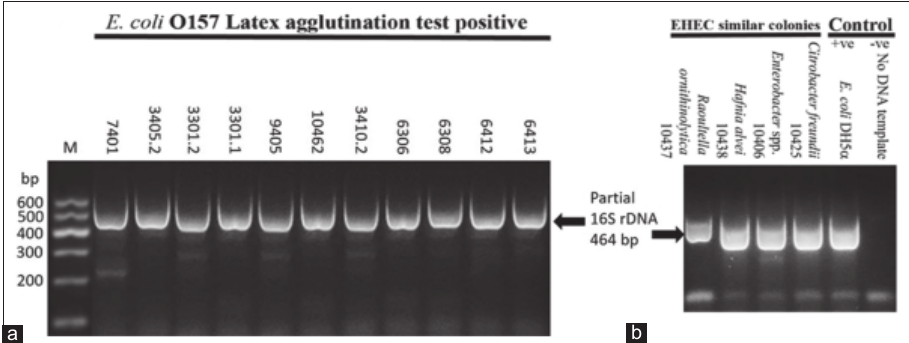
Figure-1: Polymerase chain reaction (PCR) amplification of 16S rDNA (464 bp) of typical bacterial colonies primarily cultivated on tellurite-cefixime-sorbitol MacConkey (TC-SMAC) and purified on Levine’s eosin-methylene blue (L-EMB) agar media. (a) Typical colonies identified as Escherichia coli and agglutinated with anti-O157 latex test. (b) Non E. coli colonies that showed similar morphological characteristic on TC-SMAC and purified L-EMB agar media. Positive and negative